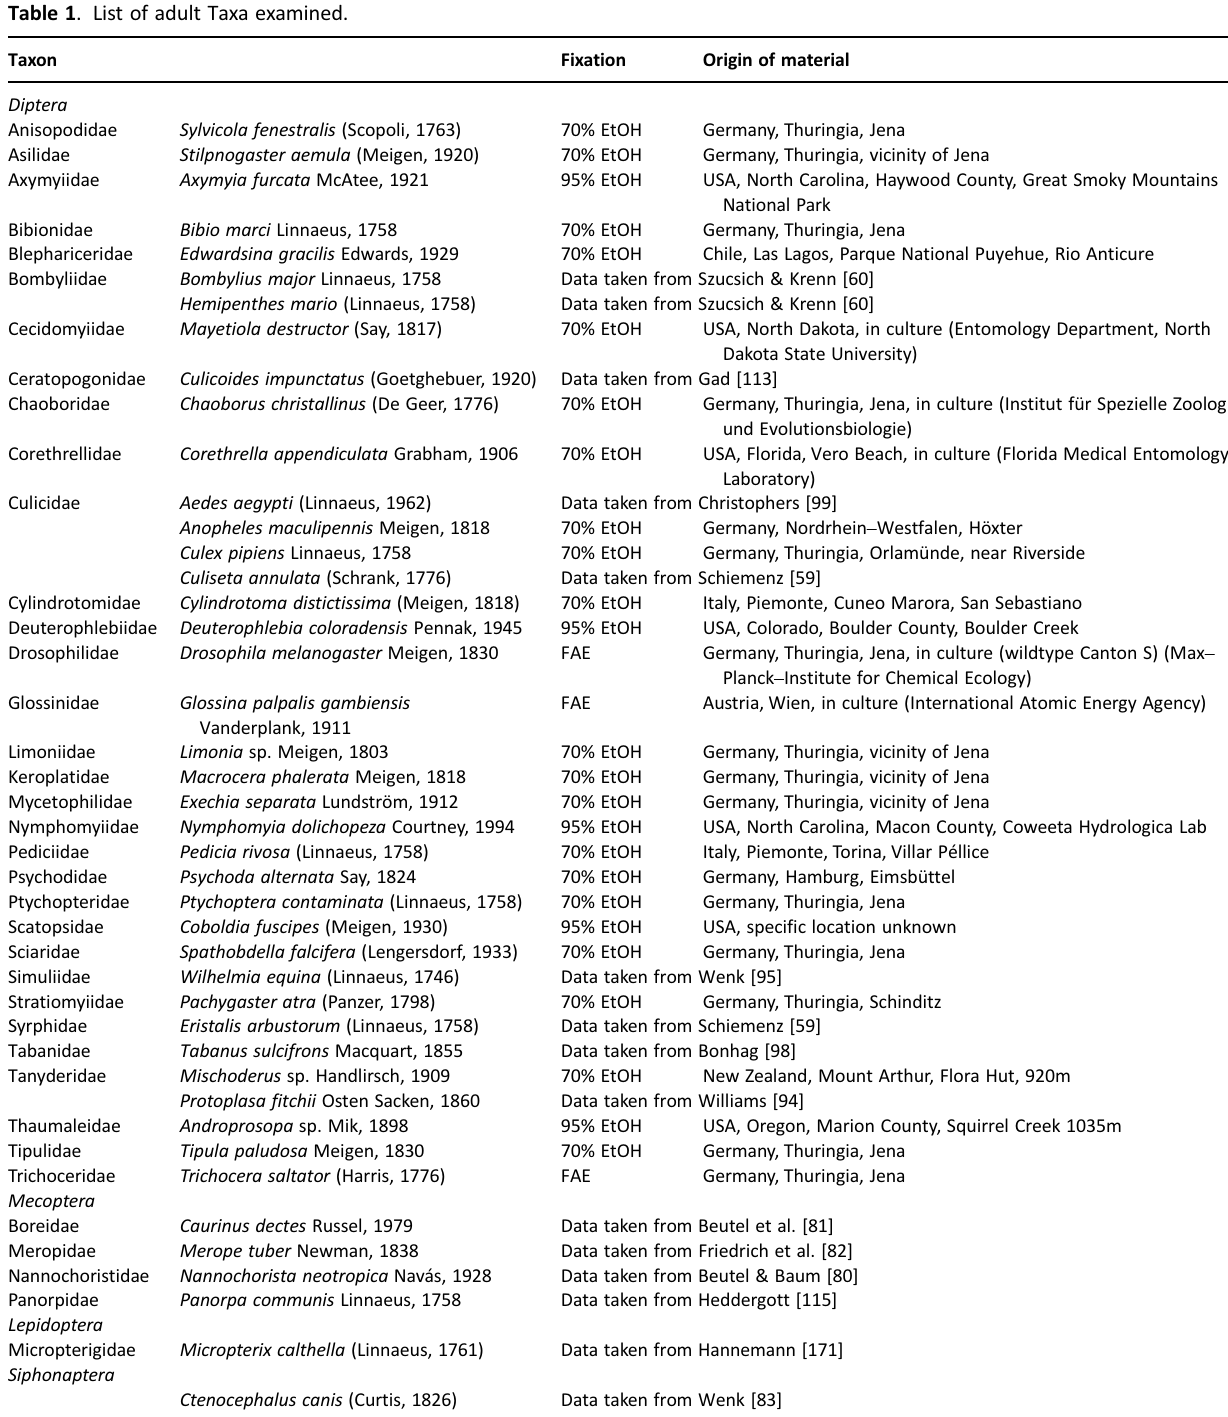
Table 1 . List of adult Taxa